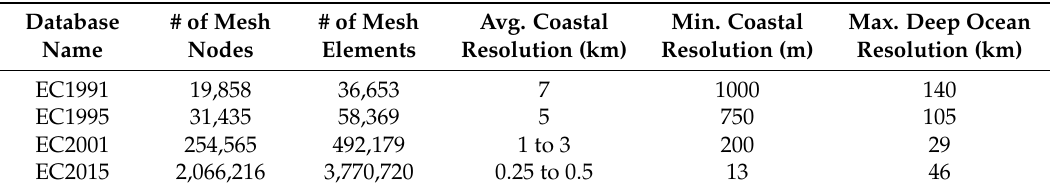
Table 1. Summary of grid features for Western North Atlantic, Caribbean and Gulf of Mexico (WNAT) domain ADvanced CIRCulation model (ADCIRC) tidal